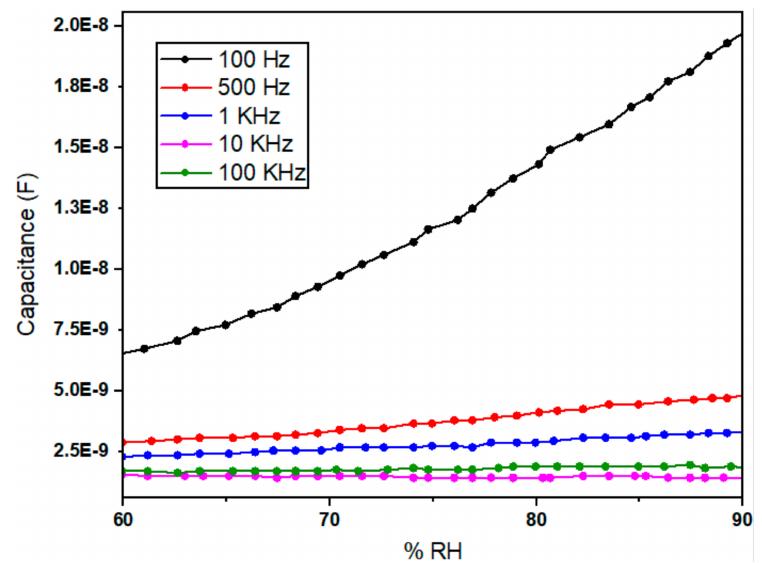
Figure 8. Magnified capacitive verses % RH response of Ppy composite based thin film sensor from 60% to 90% humidity range and showing linear behavior for a lower frequency of 100 Hz.